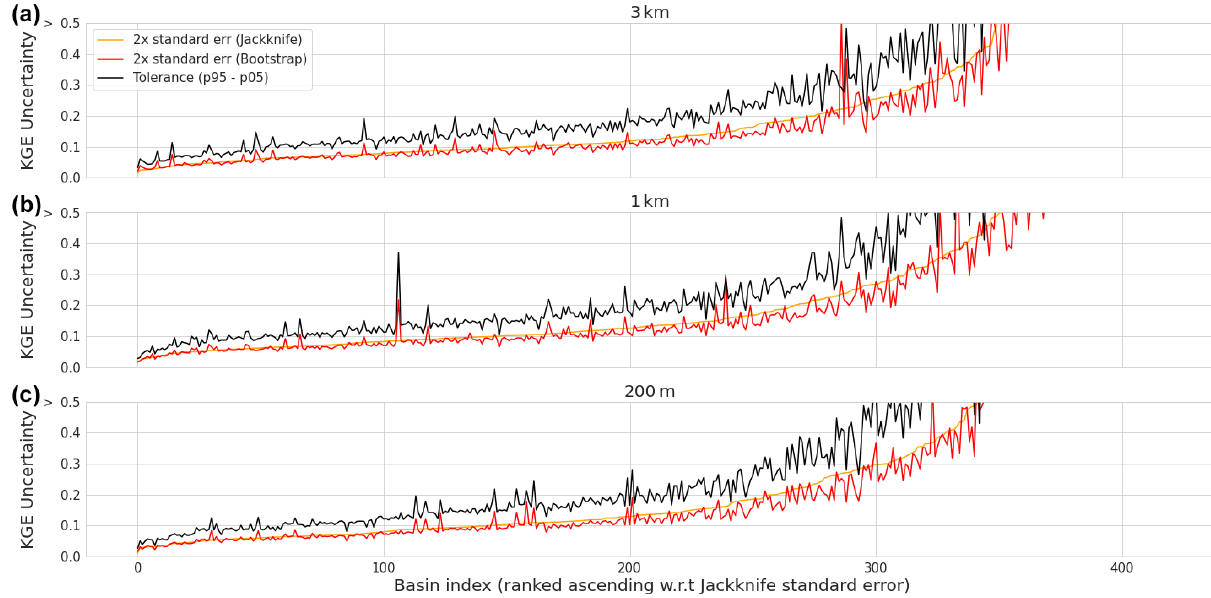
Figure 9. Evaluation period results. The bootstrap and jackknife-after-bootstrap results of the sampling uncertainty of the KGE score. The 2 × standard error of the jackknife method is shown in orange, the 2 × standard error of the bootstrap method is shown in red, and the tolerance interval obtained by subtracting the 5th percentile from the 95th percentile is shown in black. The horizontal axis shows the basin index ranked w.r.t. the jackknife standard error and the vertical axis shows the modified KGE score sampling uncertainty. (a) The 3km model instance results. (b) The 1km model instance results. (c) The 200m model instance